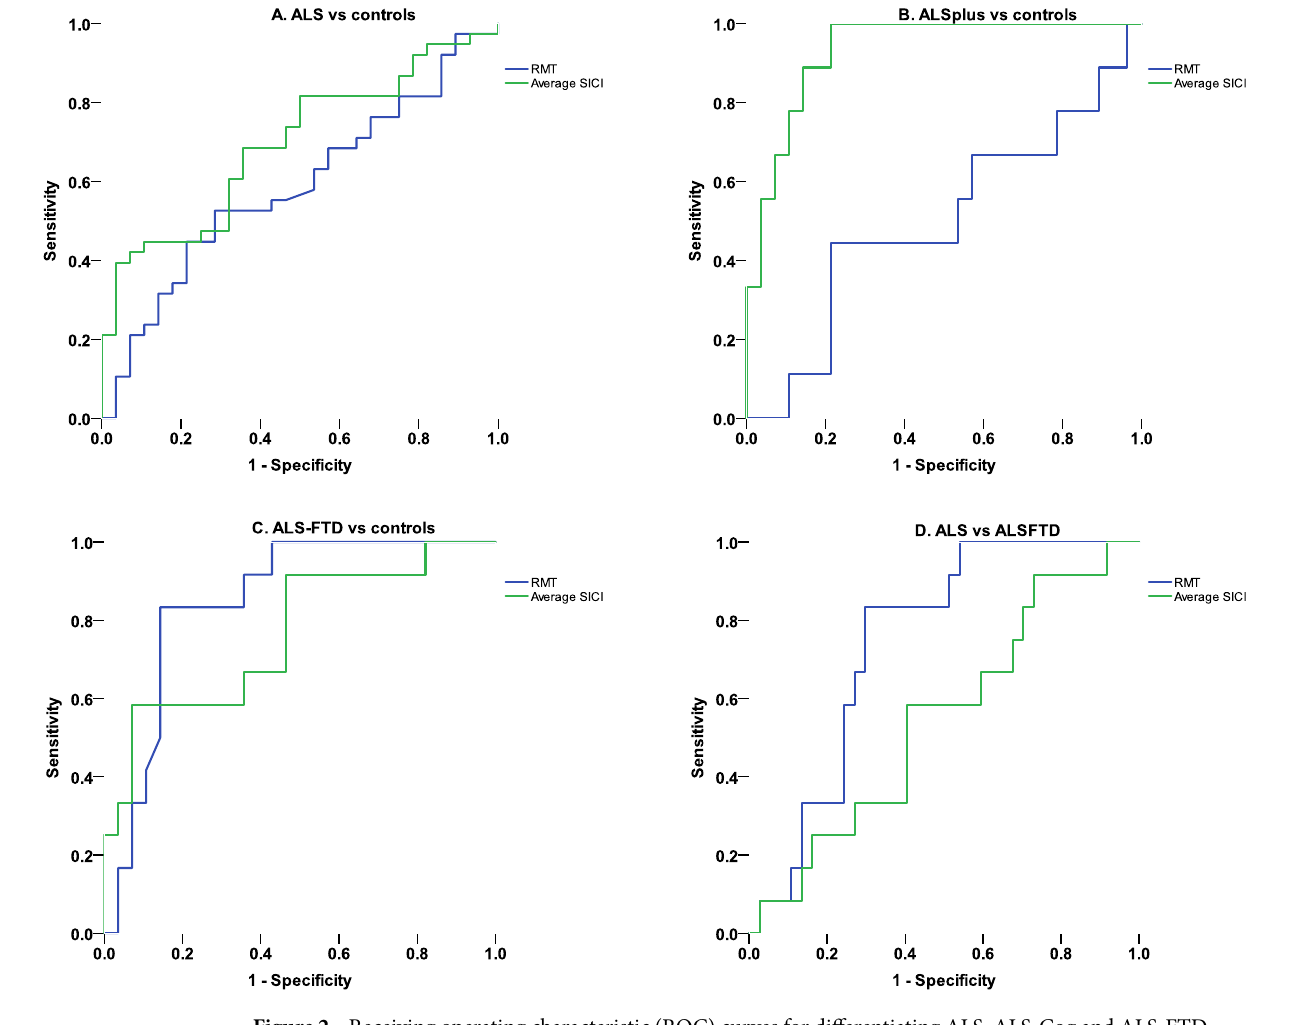
Figure 2. Receiving operating characteristic (ROC) curves for differentiating ALS, ALS-Cog and ALS-FTD from controls. ( A ) Receiver operating characteristic (ROC) curves for differentiating ALS from healthy controls with area under the curve (AUC = 0.586, p = 0.233 for RMT and AUC = 0.695, p = 0.007 for average SICI) ( B ) ROC curves for differentiating ALS-Cog from healthy controls with area under the curve (AUC = 0.500, p = 1 for RMT and AUC = 0.933, p < 0.001 for average SICI) ( C ) ROC curves for differentiating ALS-FTD from healthy controls with area under the curve (AUC = 0.850, p = 0.001 for RMT and AUC = 0.765, p = 0.009 for average SICI) 2D) ROC curves for differentiating ALS from ALS-FTD with area under the curve (AUC = 0.745, p = 0.011 for RMT and AUC = 0.547, p = 0.625 for average